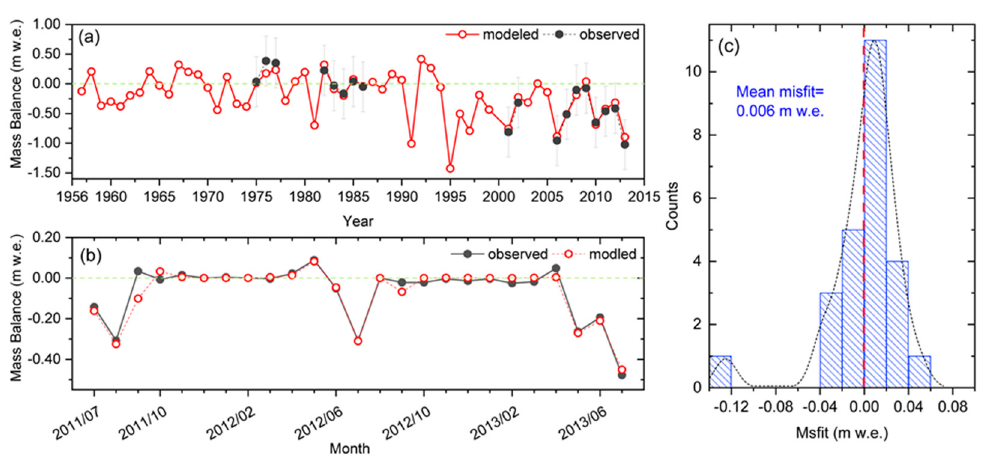
Figure 6. Evaluating modeled SMB against in-suit observations at Qiyi glacier. Linear plots ( a , b ) refer to the modeled annual and monthly glacier-wide SMB vs. observations. The frequency of misfits ( c ) is modeled vs. measured glacier-wide monthly SMB. Error bars in ( a ) indicate the 1 δ standard deviation. In ( a , b ), dashed green lines mean the zero of SMB. In ( c ), the dashed red line represents the zero misfit.